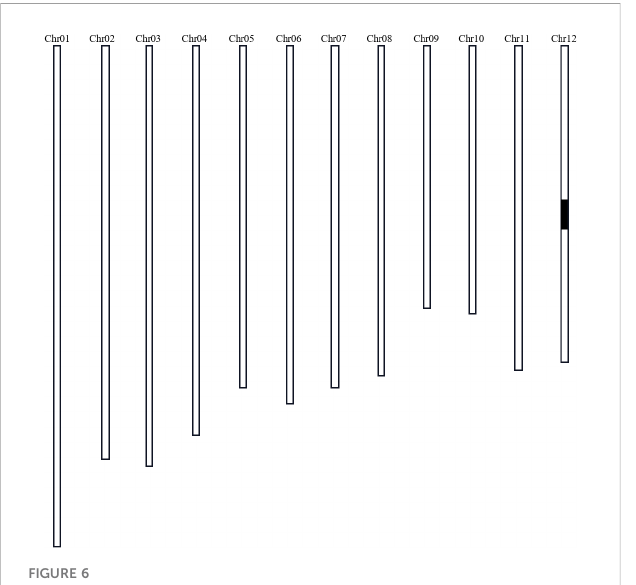
FIGURE 6 Graphical genotype of CSSL12 (a substitution line of chromosome 12). Black bar indicates the genome fragment from HZ; the other parts were from Nekken2.